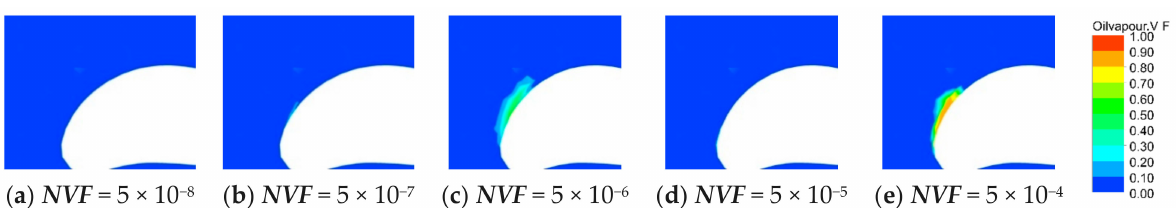
Figure 17. Oil vapor volume fraction distribution in stator domain at stall under various nuclei volume